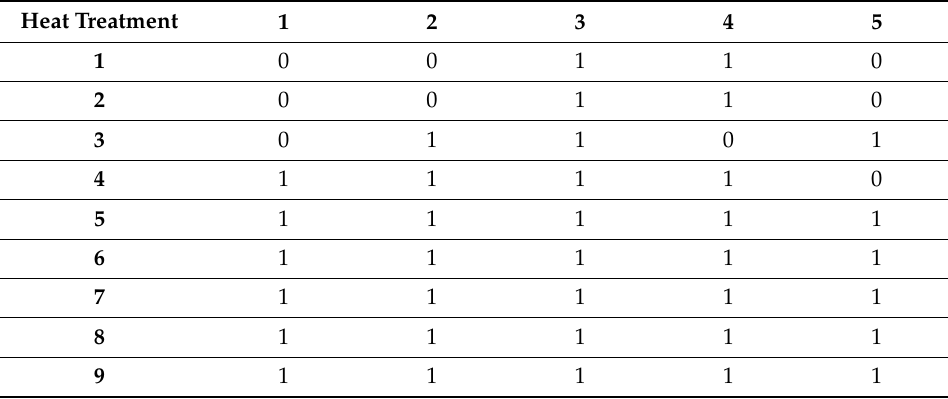
Table 2. Heat treatment to furnace service combinations